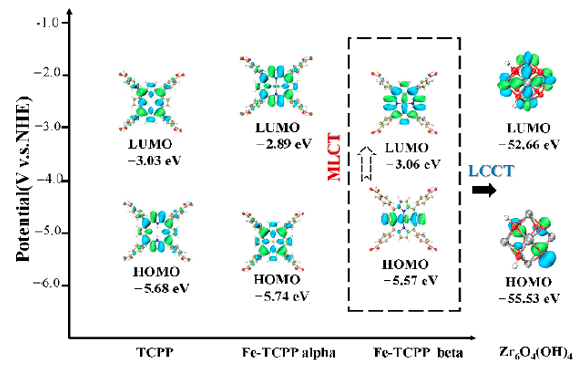
Figure 5. Distribution of orbital energy of TCPP, Fe-TCPP, and Zr 6 O 4 (OH) 4 .